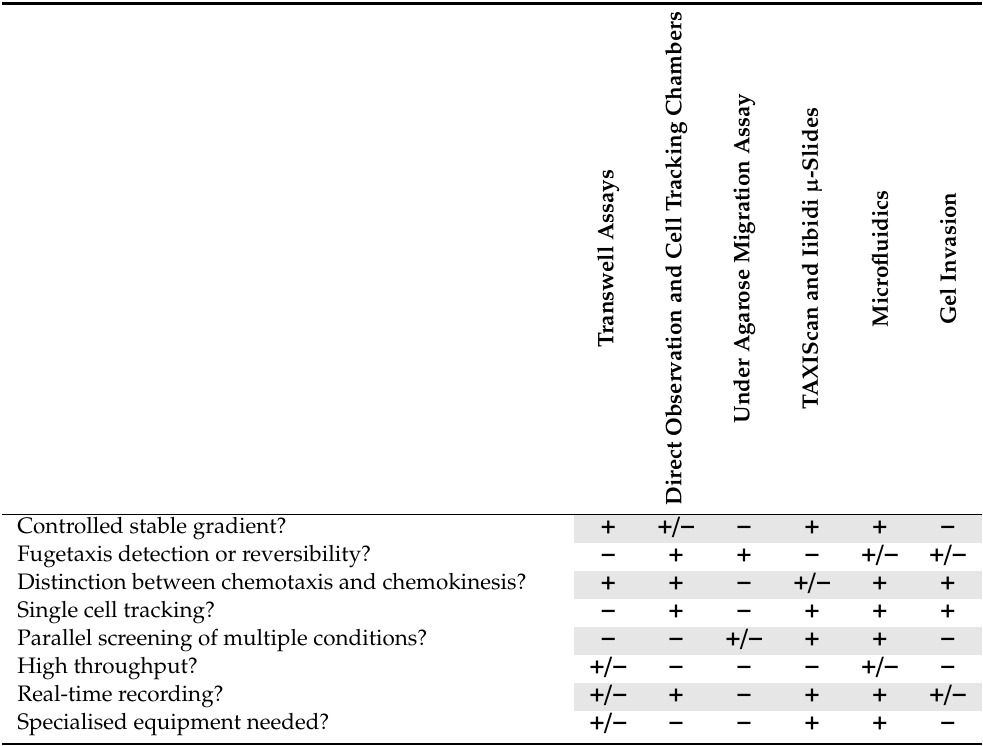
Table 1. Comparison of popular chemotaxis assays based on Harris’ criteria and desirable features for current needs in chemotaxis research. Inspired by Frow et al. (2004)